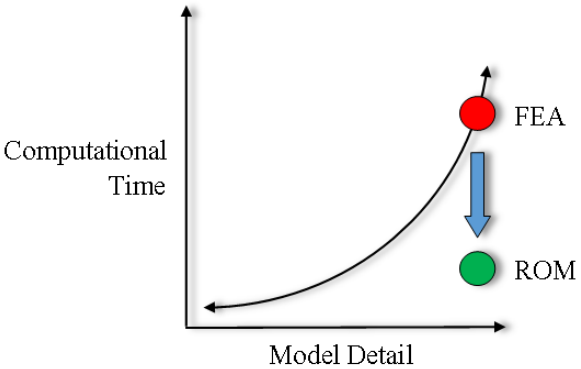
Figure 1. Non-reduced rotor dynamics models typically have a simulation performance tradeoff between the computational efficiency and model detail. Finite element analysis (FEA) tends to be at the upper end of the curve. A good reduced-order model (ROM) decreases the computational cost without decreasing the detail, which can affect the simulation accuracy.